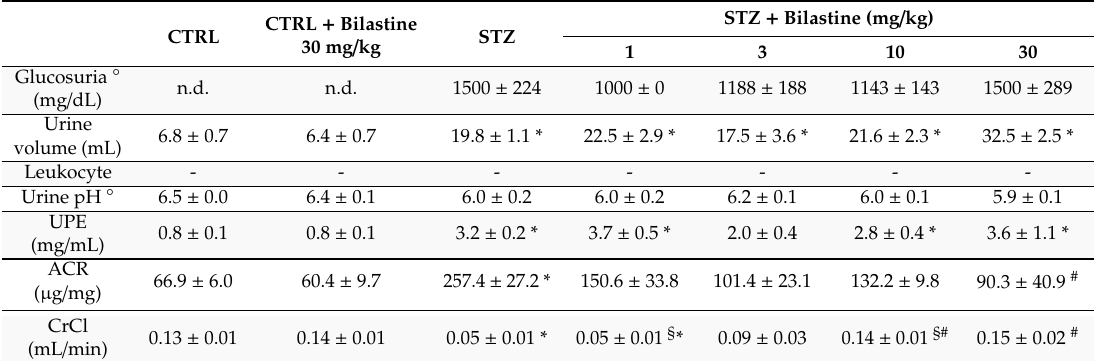
Figure 1. Diagram of the experimental design describing group allocation ( n = 10 animals/per group). CTRL = control; STZ = streptozotocin; i.p. = intraperitoneal injection; o.g. = oral gavage. Table 1. Renal function parameters at week 14 after diabetes